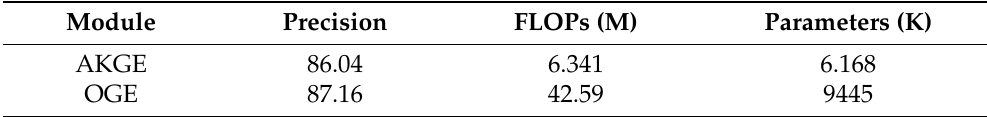
Table 5. Memory footprint and inference time of modules on MegaDepth.